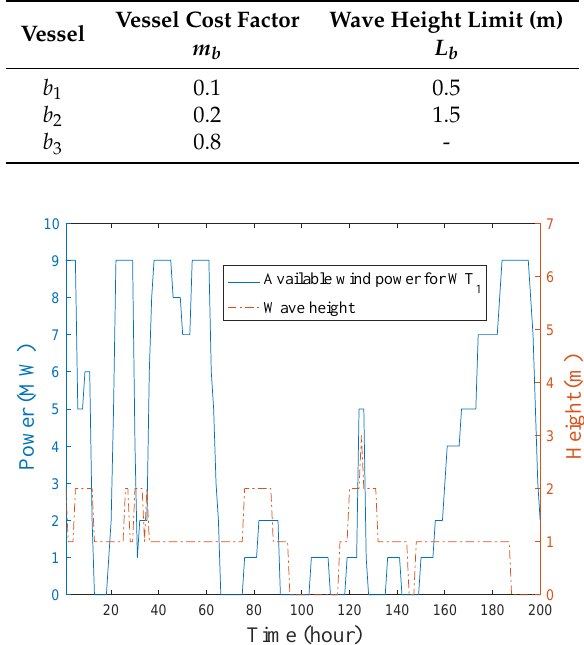
Figure 3. Available wind power and wave height in deterministic